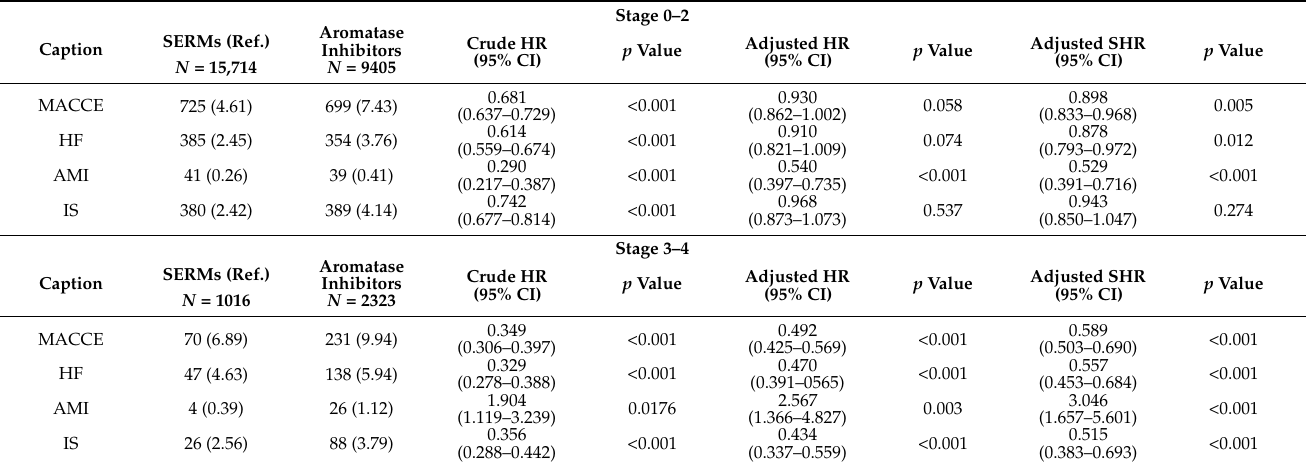
Table 4. The crude and adjusted hazard ratio (HR) of MACCE, AMI, HF and ischemic stroke in users of SERMs and AIs in breast cancer patients at different cancer stages.